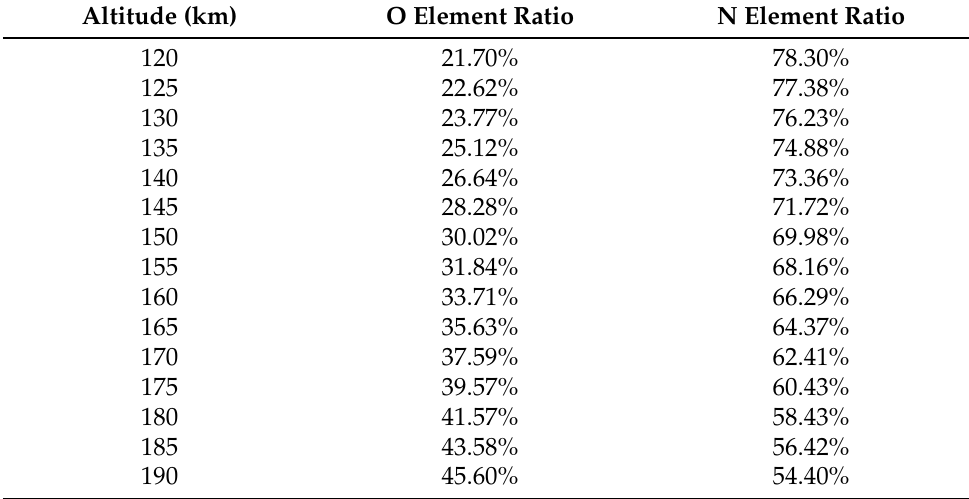
Table 3. The proportion of O and N in the line of sight at different altitudes. Altitude